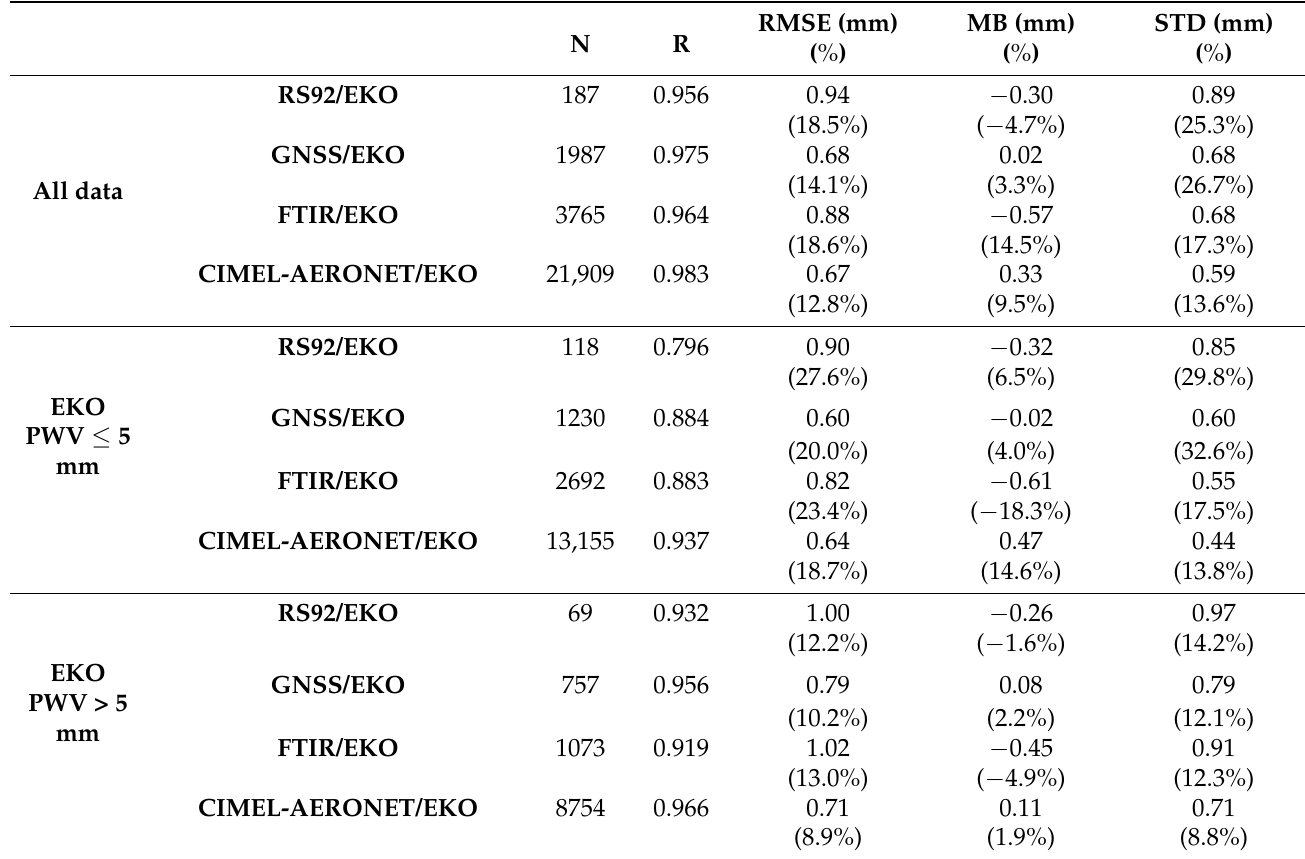
Table 2. Statistics of the comparison between EKO PWV (mm) determined between 930 and 960 nm and the PWV obtained from of RS92, GNSS, FTIR and CIMEL-AERONET at IZO between April and December 2019. (N: number of data, R: Pearson correlation coefficient, RMSE: root mean square error, MB: mean bias, STD: standard deviation).